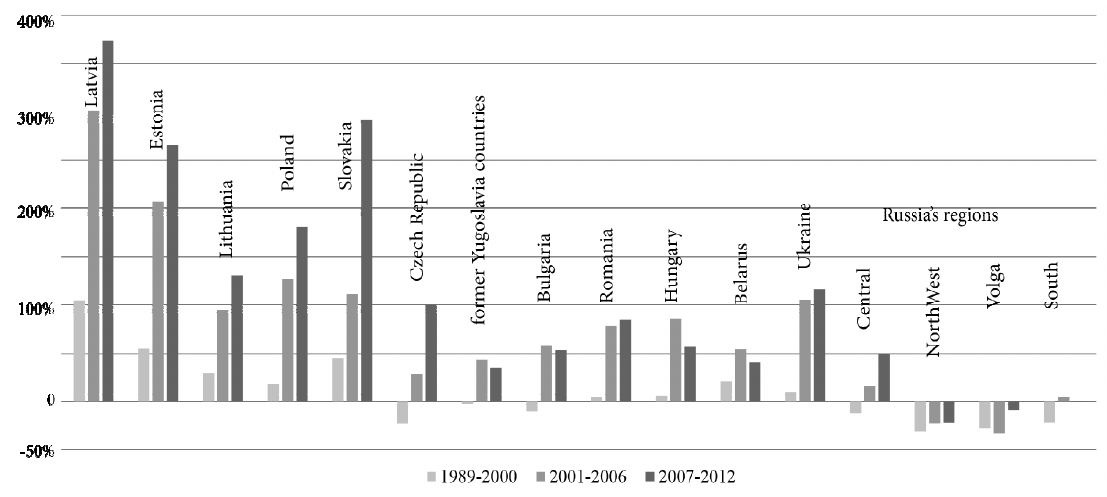
Figure 2. Difference of national and regional annual logging area relative to Soviet era